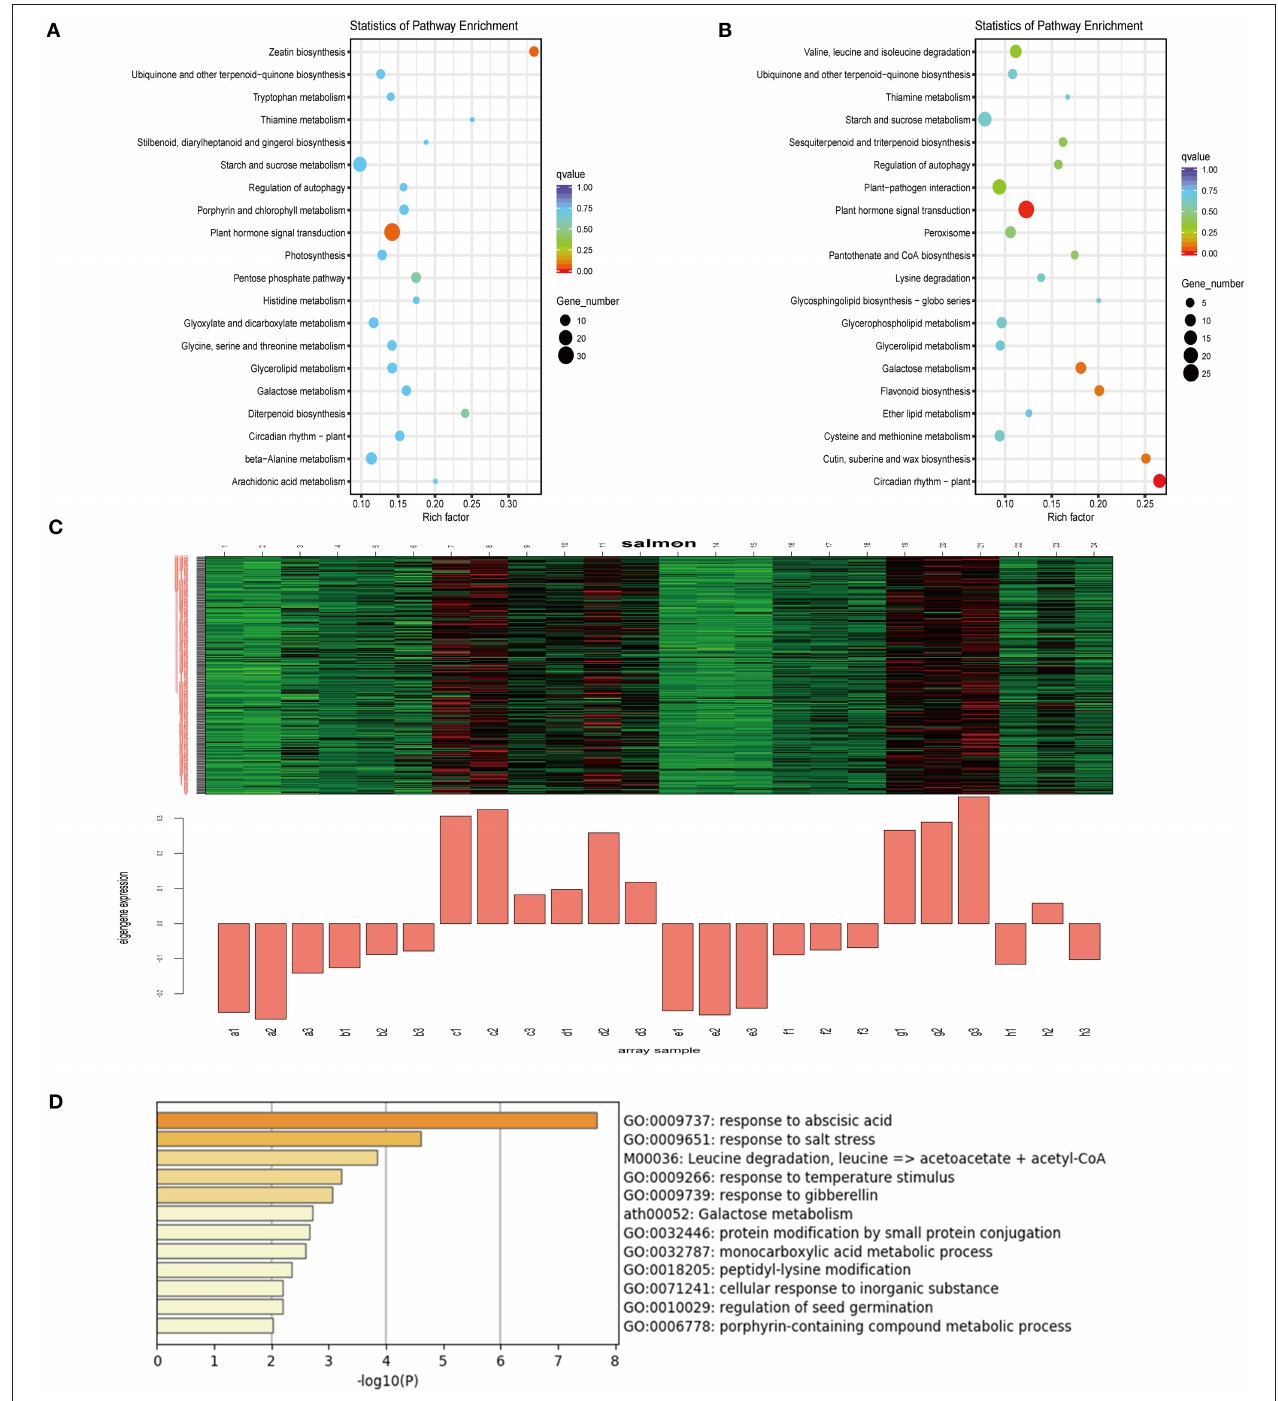
FIGURE 3 | KEGG enrichment analysis of the DEGs on the 9th day and Weighted gene co-expression network analysis (WGCNA) of differentially expressed genes (DEGs) identified in drought treated and control over three sampling time points (5, 9, and 15 days) during drought stress. (A,B) The 20 most significantly enriched KEGG pathways for DEGs in response to drought after nine days in diploids (2X) (A) and triploids (3X) (B) . (C) Salmon module eigengene expression values across all the samples. The upper portions of (D) figure is heat maps of the expression values of each gene (row) in each sample (column): red—highly expressed; green—lowly expressed; black—neutral; Control: (a: CK-2X, e: CK-3X); Severe drought with 5 days: (b:SD-2X-5, f:SD-3X-5); Severe drought with 9 days: (c: SD-2X-9, g: SD-3X-9); Severe drought with 15 days: (d: SD-2X-15, h: SD-3X-15). CK: control; SD: severe drought. (D) Pathway and process enrichment analysis. Each term is represented by a circle node, where its size is proportional to the number of input genes that fall into that term, and its color represent its cluster identity.